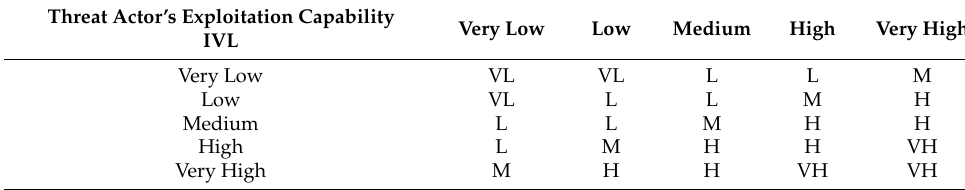
Table 3. Cumulative exploitability vulnerability